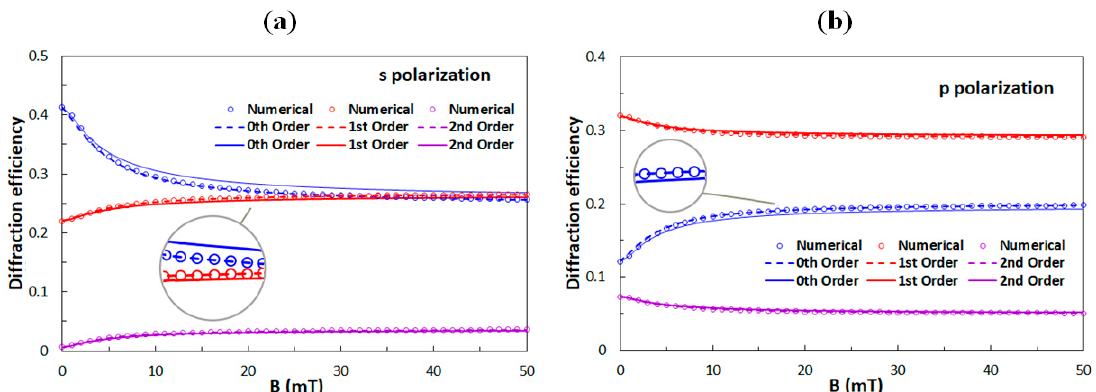
Figure 6. Diffraction efficiencies of the 0th, 1st, and 2nd diffraction orders as a function of the applied external magnetic field for ( a ) the s-polarized and ( b ) for the p-polarized incident beam. The anchoring strength is W = 1 μ J/m 2 . Circles are obtained with the numerical solution for θ ( x ), while solid lines are results for θ ( x ) obtained by Equation (9) and dashed lines for θ ( x ) obtained by Equation (10).